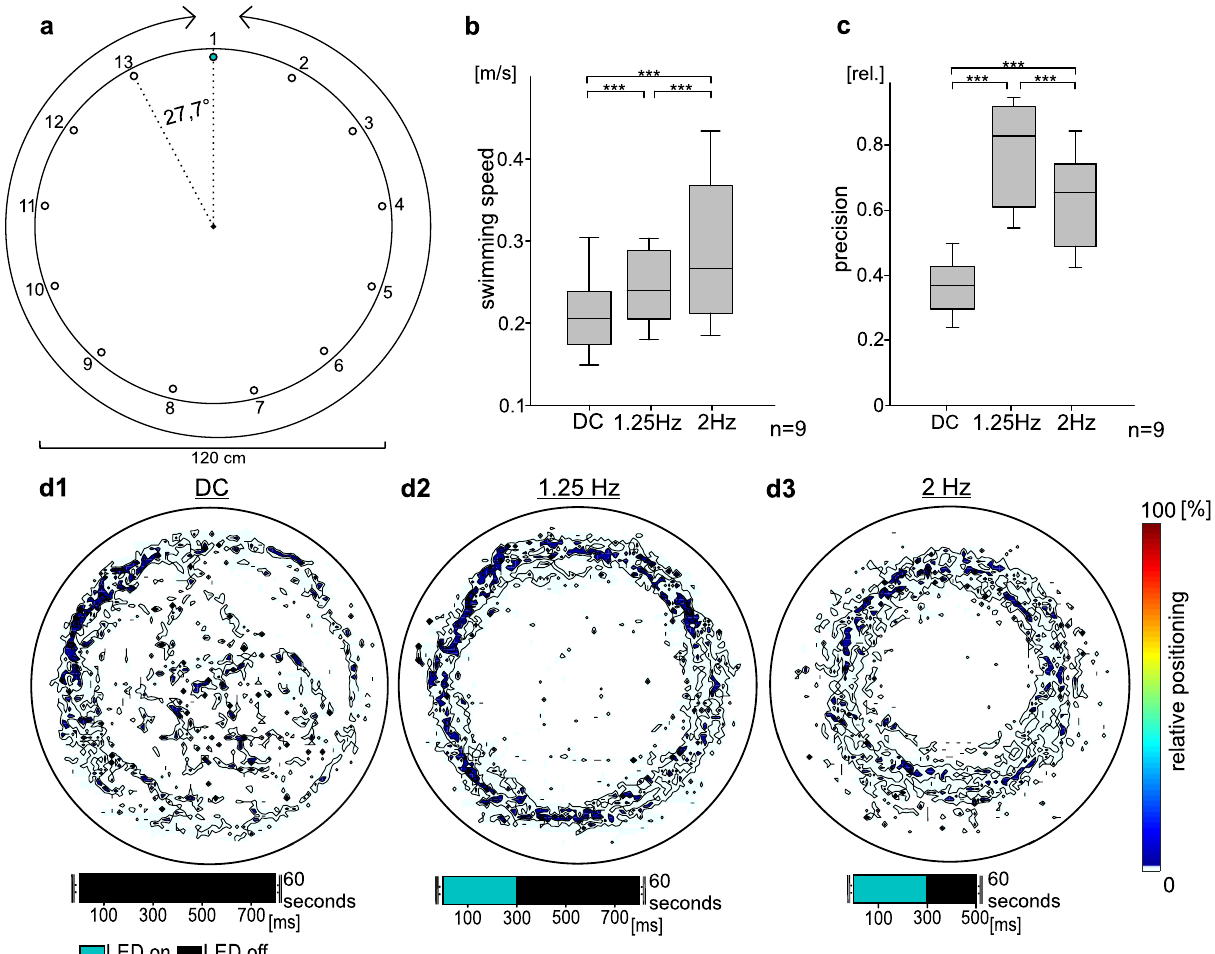
Figure 3. Anomalops katoptron are motivated to follow a moving light source. ( a ) Experimental setup with 13 wall mounted LEDs that were triggered consecutively counter- or clockwise with different frequencies. ( b ) Mean swimming speed of isolated A. katoptron during no light (DC) and light stimulation (1.25 and 2 Hz) (n = 9). ( c ) Relative distance between A. katoptron and the center of the tank according to the motivation of individuals to follow the moving light source (n = 9). ( d ) Heat Maps indicate positioning of A. katoptron during no light ( d1 ) or light stimulation ( d2 , d3 ) (n = 9). Each heat map shows the average of five trials for one isolated specimen. Figures were created with SigmaPlot 12.0 (www. sigma plot. co. uk) and processed with CorelDraw Graphics Suite 2017 (www. corel draw. com). DC, dark control; * p < 0.05, ** p < 0.01, *** p <